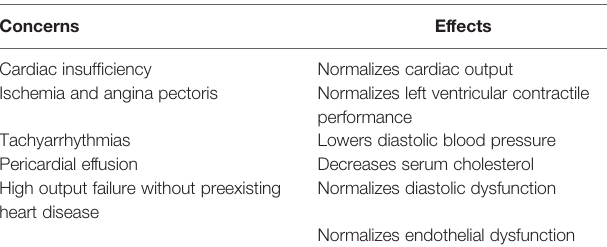
TABLE 4 | Treatment of hypothyroidism with levothyroxine — cardiac concerns and effects on these risk factors.